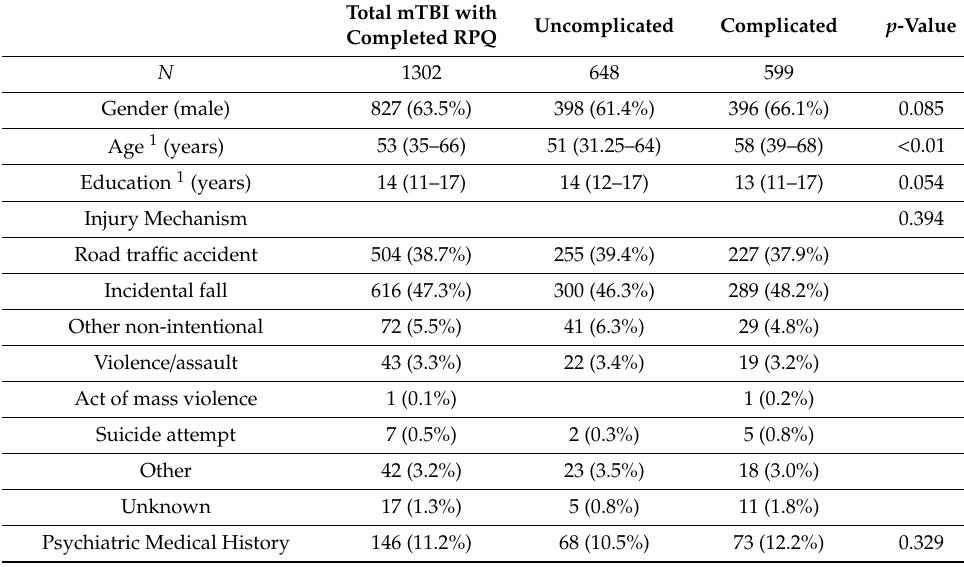
Table 2. Characteristics of the study